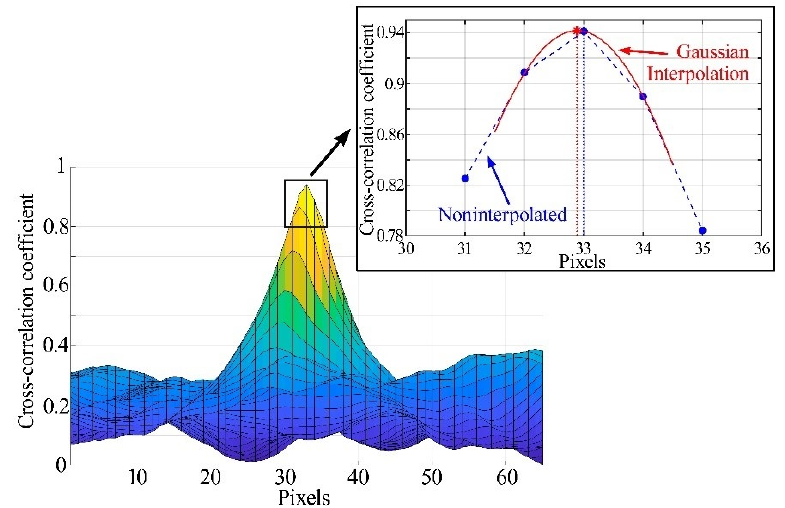
Figure 3. An example of the 1D cross-correlation coefficient.